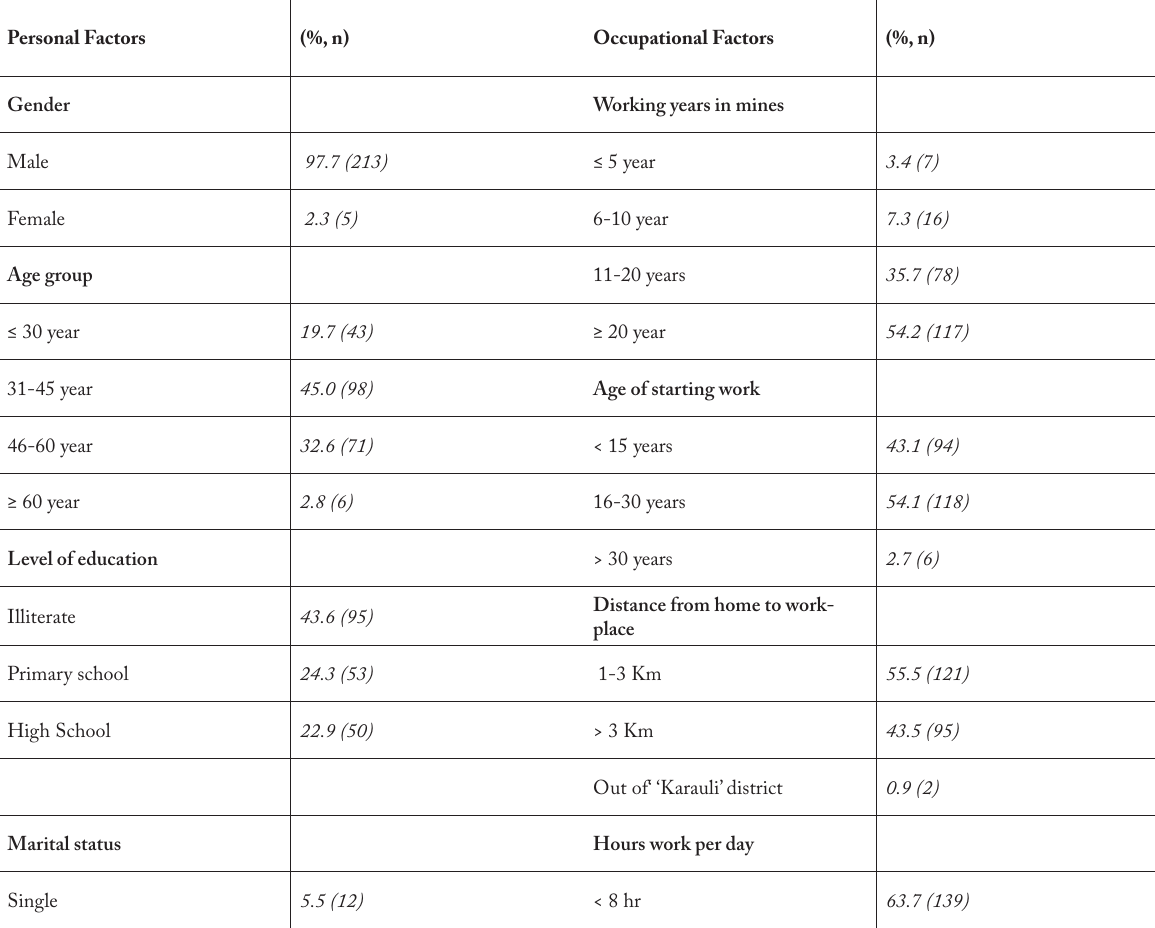
Table 1. Personal and occupational factors among mine workers from block ‘Karauli’, Karauli district, Rajasthan, India ( n =